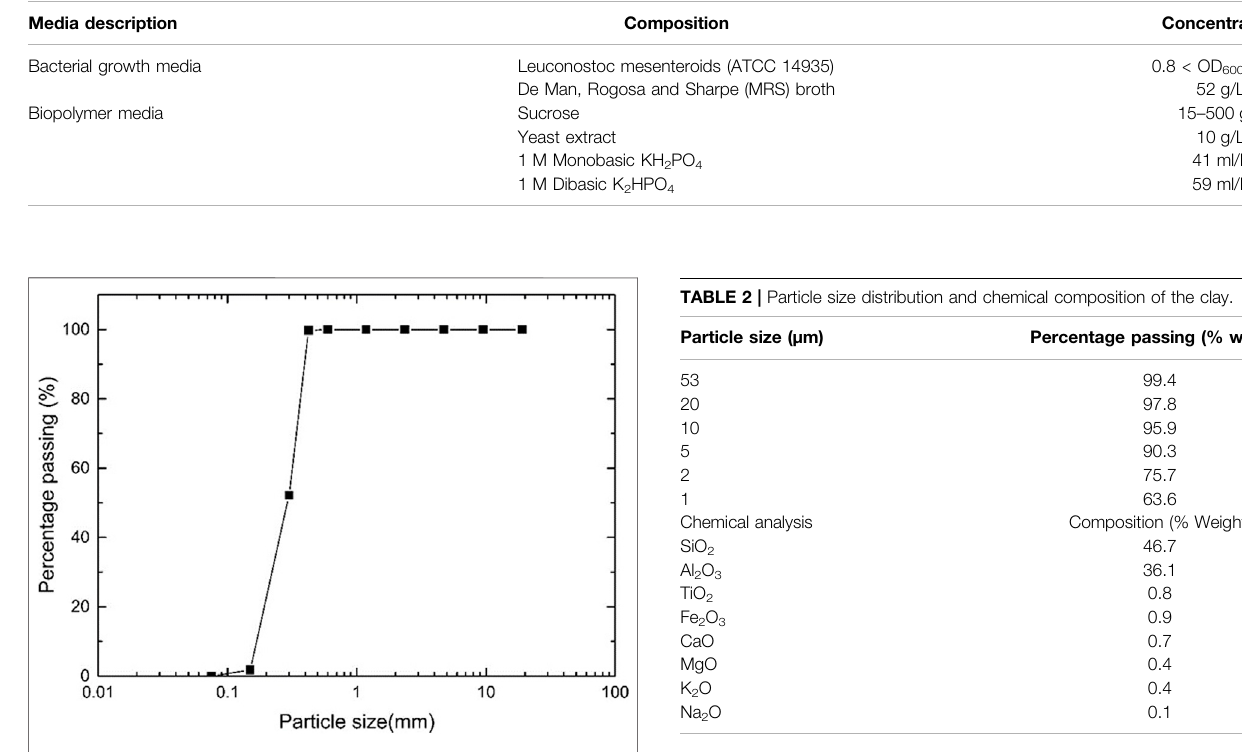
FIGURE 1 | The particle size distribution of the manufactured sand.